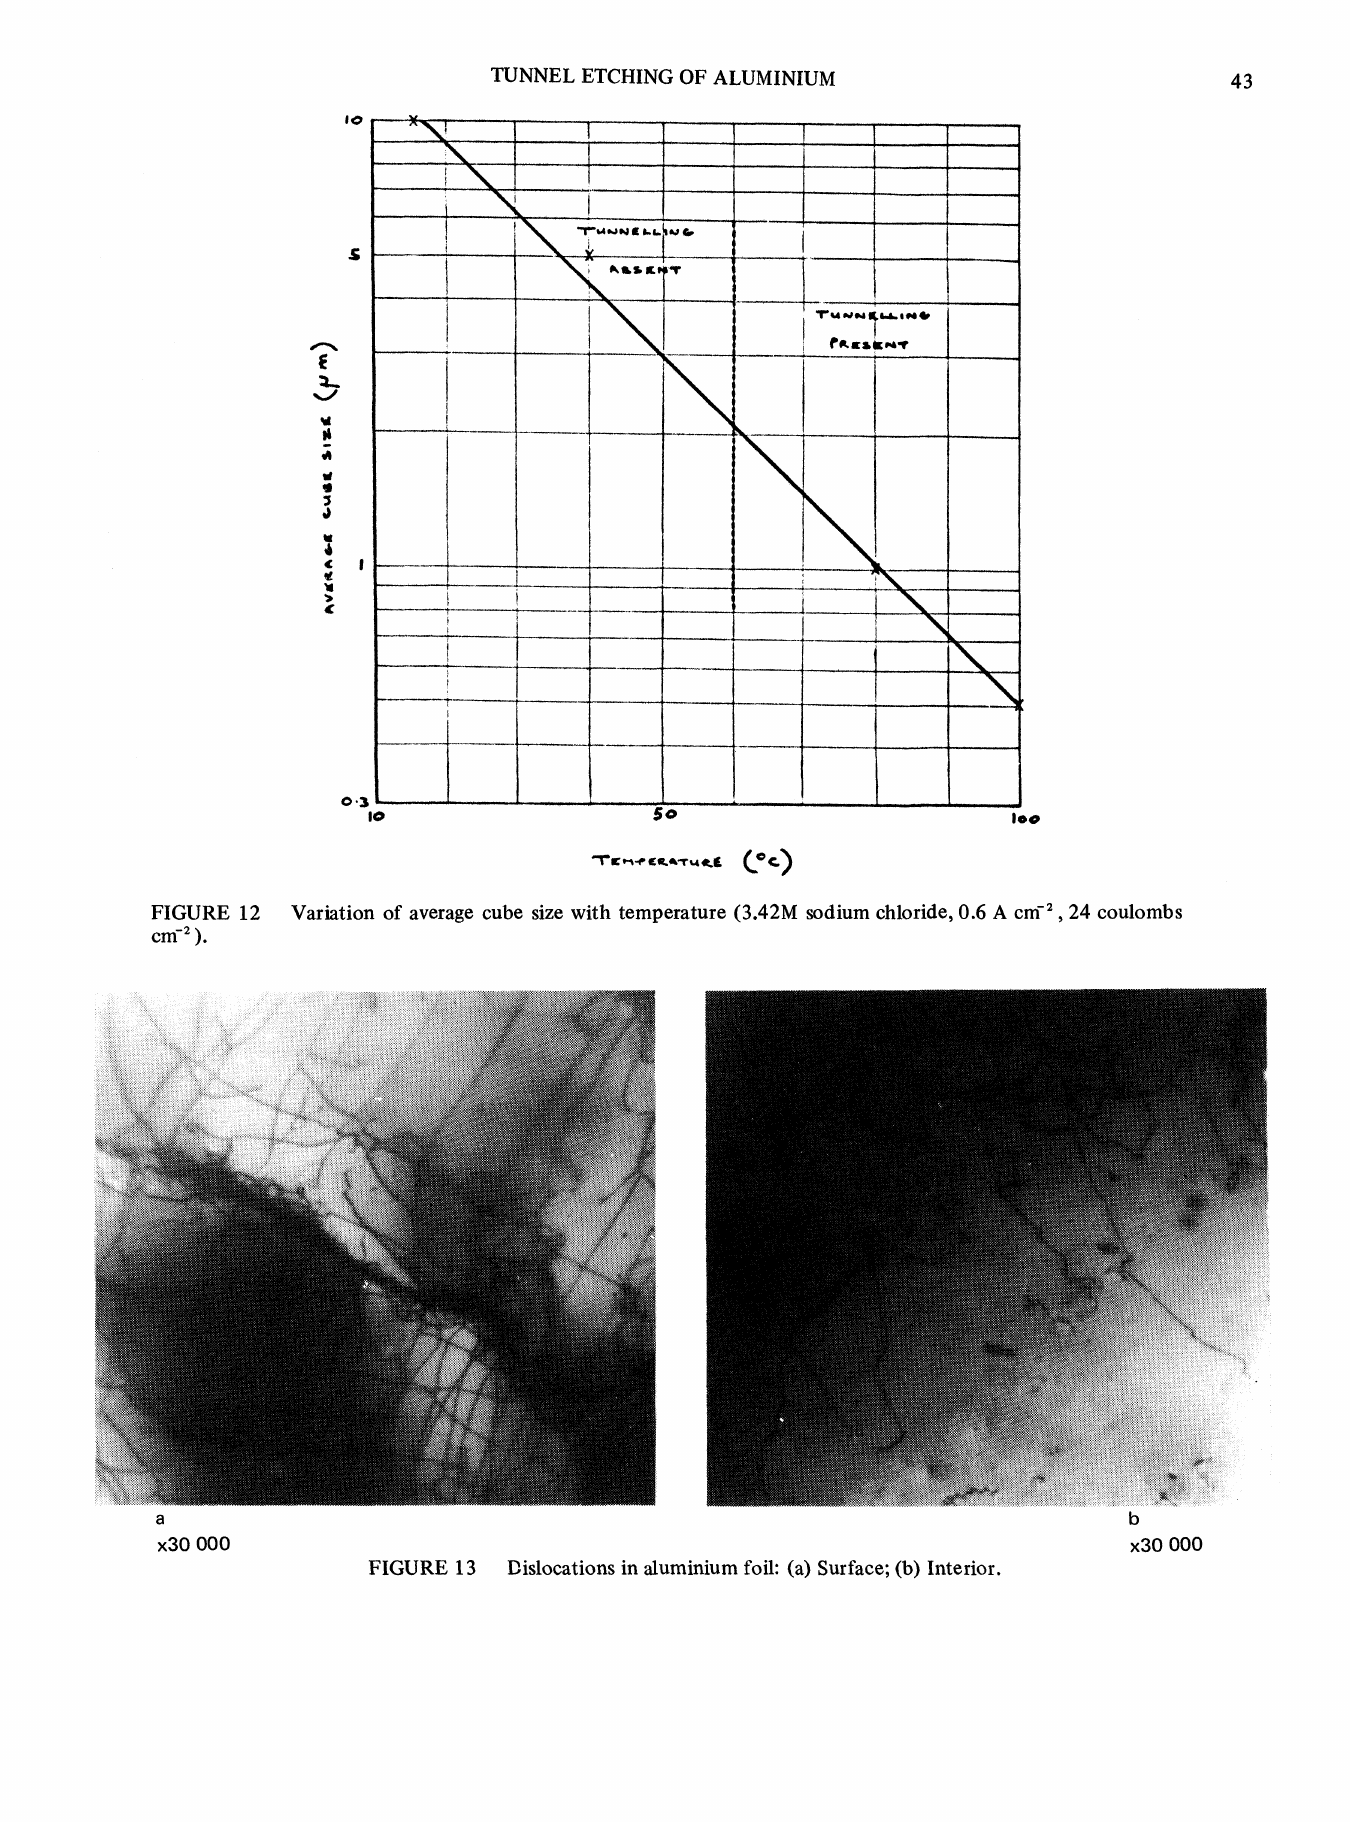
FIGURE 13 13islocations in aluminium foil: (a) Surface; (b) Interior.